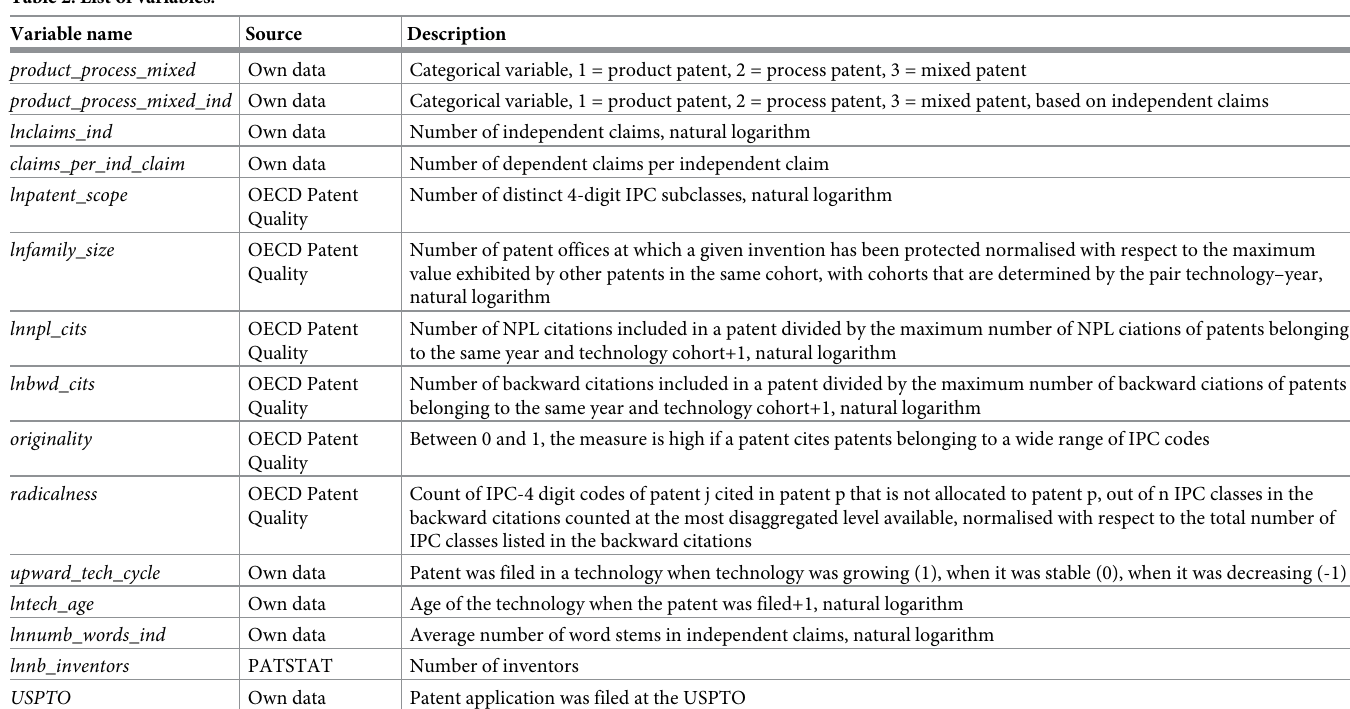
Table 2. List of